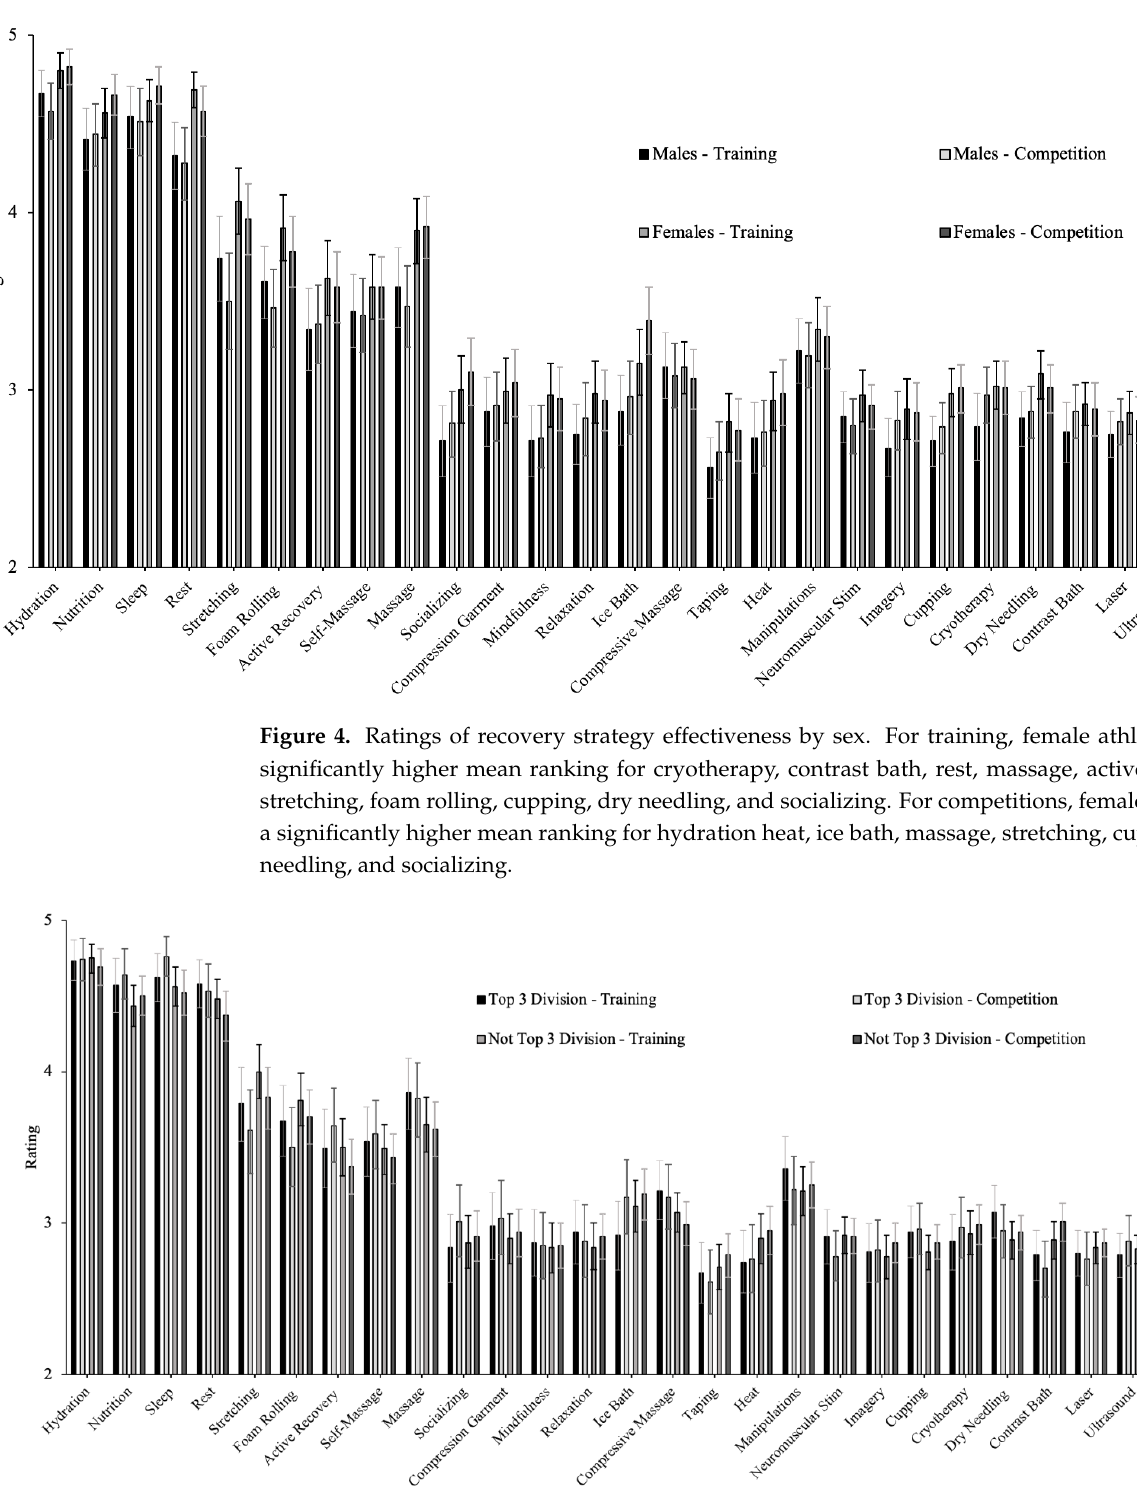
Figure 5. Ratings of recovery strategy effectiveness by competition outcomes — top three placement in the division. Placing the top three in the division had a significantly higher mean ranking for sleep, nutrition, compressive massage, and active recovery following competition and for nutrition and massage following training. Athletes who were not top three in their division had a significantly higher mean ranking for contrast baths.